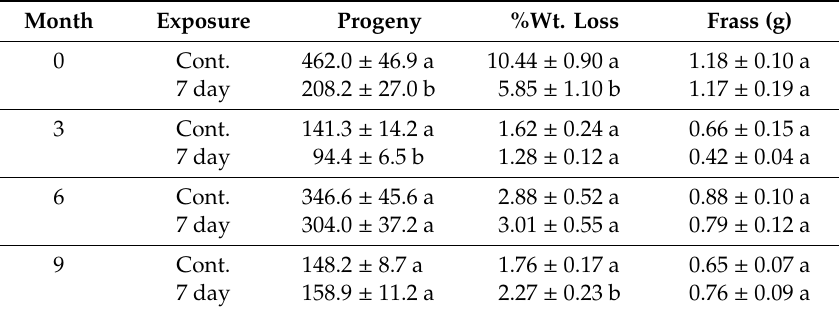
Table 15. Data for S. oryzae combined for treatments since overall ANOVA showed no treatment e ff ect. Number of F 1 adult progeny, % of sample weight loss due to insect feeding, and feeding damage (frass) (mean ± SE for all) from exposure of ten mixed-sex parental adult S. oryzae exposed continuously for about 8 weeks (Cont.) on ~80 g of untreated brown rice, or adults removed after 7 days of exposure (7 day). Only comparison between the two parental exposure regimes were done. Data are separated by month, bioassays were done at 1 day (month 0), and 3, 6, 9 months after treatment 1